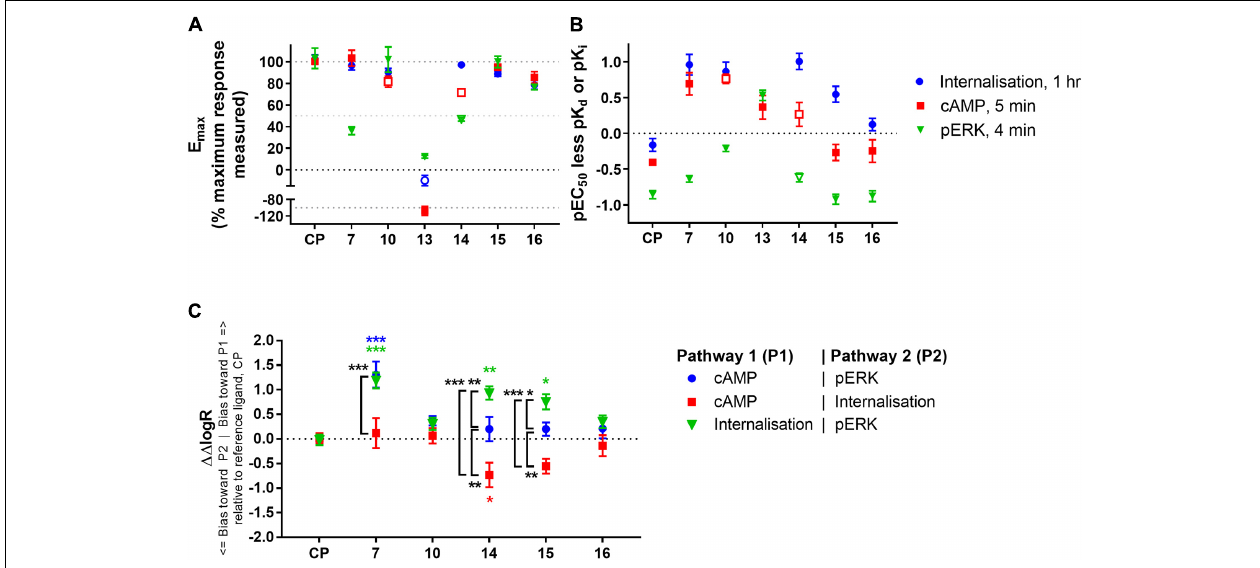
FIGURE 5 | Comparison of ligand efficacy, potency (relative to binding affinity), and signalling pathway bias for CP 55,940 and 2,4,6-trisubstituted 1,3,5-triazines. (A) Internalisation, inhibition of cAMP production and stimulation of pERK E max for each compound normalised to the overall maximum response measured at a single concentration in each pathway. Hollow symbols represent efficacy measures where conclusive E max values could not be determined; for 10 and 14 cAMP E max is approximate due to the presence of non-hCB 2 -mediated effects, for 14 pERK and 13 internalisation efficacy at 10 µ M is plotted because fully-defined concentration-response curves could not be drawn. (CP, CP 55,940) (B) pEC 50 for the three signalling pathways indicated less pK d (for CP 55,940, CP) or pK i (for the 2,4,6-trisubstituted 1,3,5-triazines). Hollow symbols represent potency measures where conclusive EC 50 values could not be determined; for 10 and 14 cAMP EC 50 is approximate due to the presence of non-hCB 2 -mediated effects, for 14 pERK EC 50 is approximate due to its low potency. (C) Between-signalling pathway bias as represented by (cid:49)(cid:49) logR in comparison with CP 55,940 (CP) as a reference ligand. 13 could not be included in the bias quantitation as it is an agonist in only one pathway. The symbol “ ∗ ” in colour indicates significant difference from CP 55,940 for the same bias comparison; The symbol “ ∗ ” in black and white indicates significant difference for the comparison indicated by the associated bracket; significance levels as defined in the methods. Data in all panels are presented as mean ± SEM from three independent